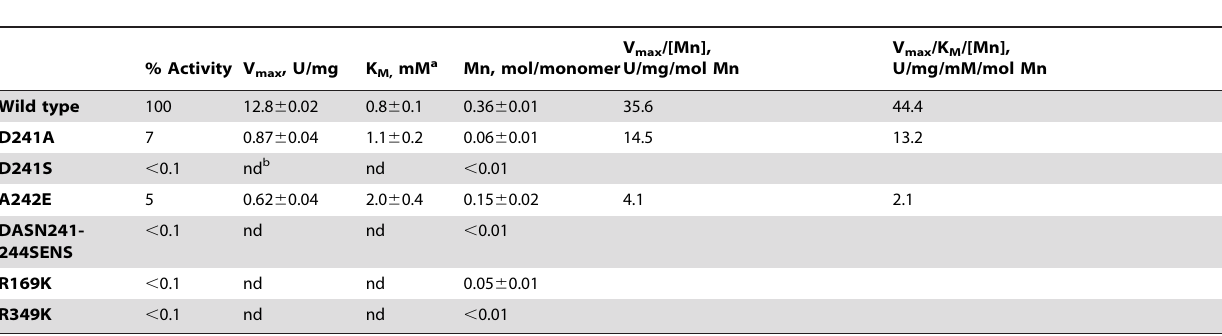
Table 1. Steady state kinetic parameters and manganese content of recombinant, wild type CsOxOx and CsOxOx